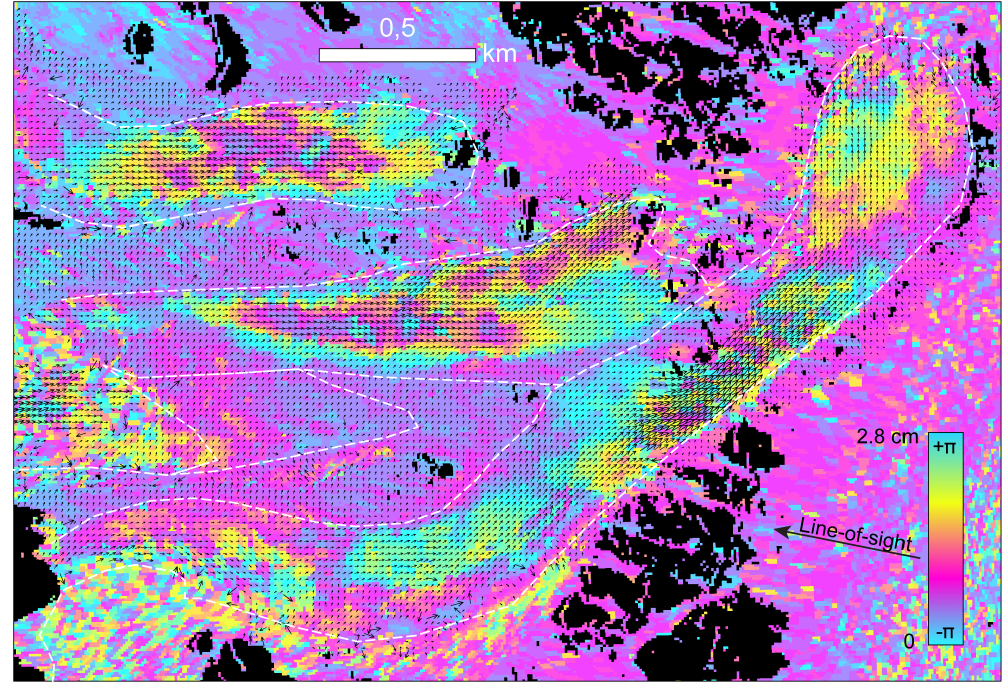
Figure 8. The Ordzhonikidze rock glacier. Section of an interferogram between Sentinel-1 radar data on 24 August and 5 September 2018 (12d; slightly smaller section than Fig. 2d) with vectors superimposed from image matching between 2016 and 2018 high-resolution satellite images (for exact dates and sensors see Table S2). The white dashed lines are the inventory outline polygons from our motion and process- type classes. Photogrammetric velocities are up to 4m/a. Similar comparisons for the other rock glaciers are displayed in the Supplement.